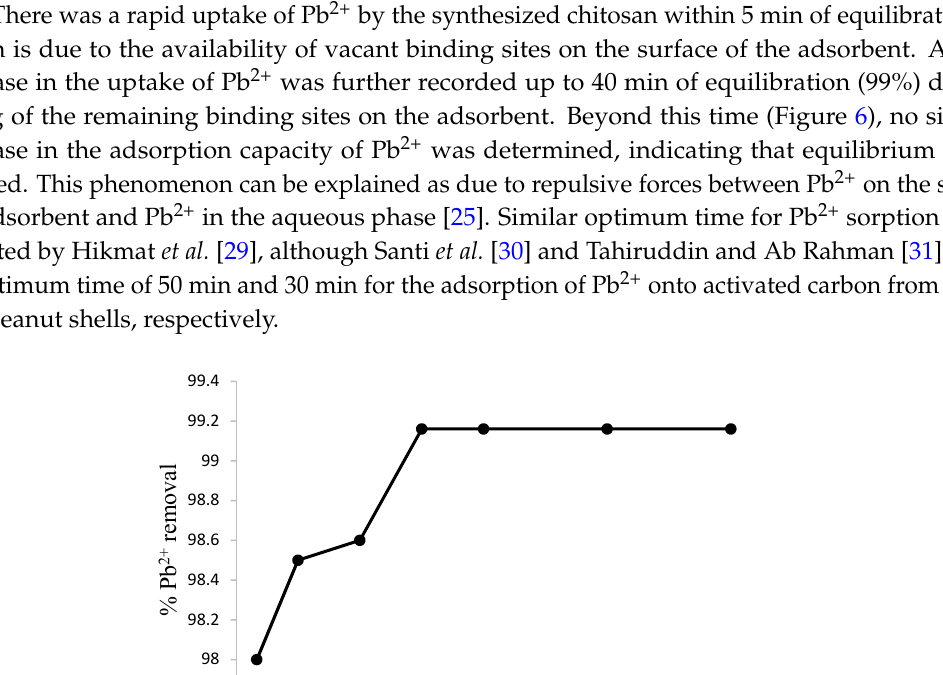
Figure 5. Variation of percent Pb 2+ ion removal with change in pH value (initial concentration = 10.7 mg/L, contact time = 40 min, T = 298 K, shaking speed = 250 rpm, adsorbent dosage = 1.0 g).